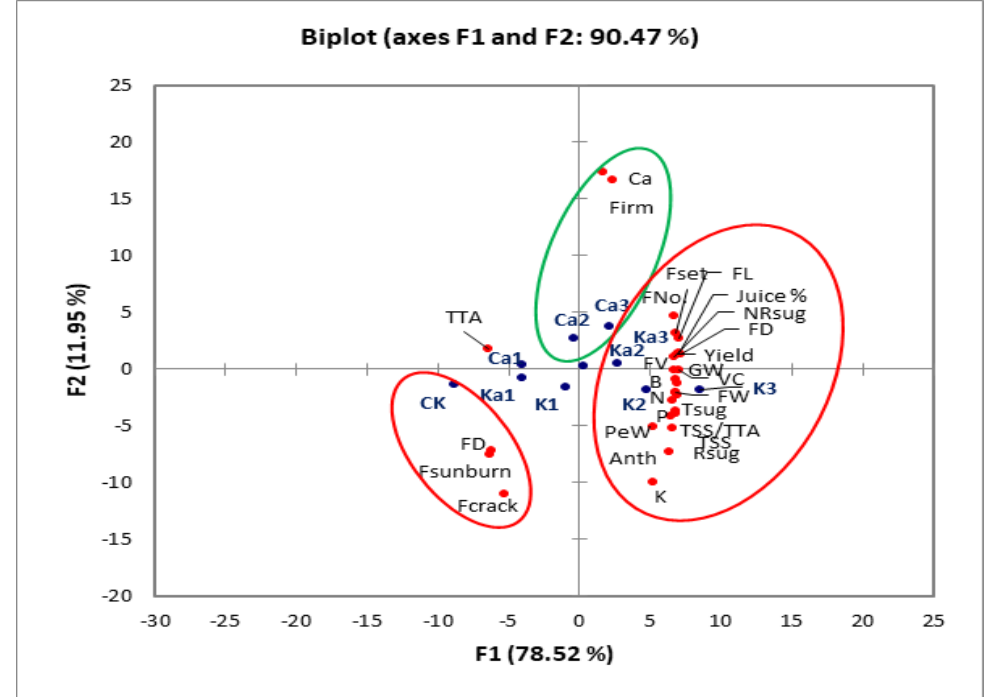
Figure 3. Principal component analysis ‶ PCA ” among potassium, calcium and kaolin treatments and fruit quality attributes of pomegranate. Clustering of treatments and measured attributes into groups ‶ colored circles ” is based on their highest squared cosine values corresponding to the factors F1 (red) or F2 “ green ” . Abbreviations: CK ‶ control K1 ” 1% ” potassium nitrate; K2 ‶ 2% ” potassium